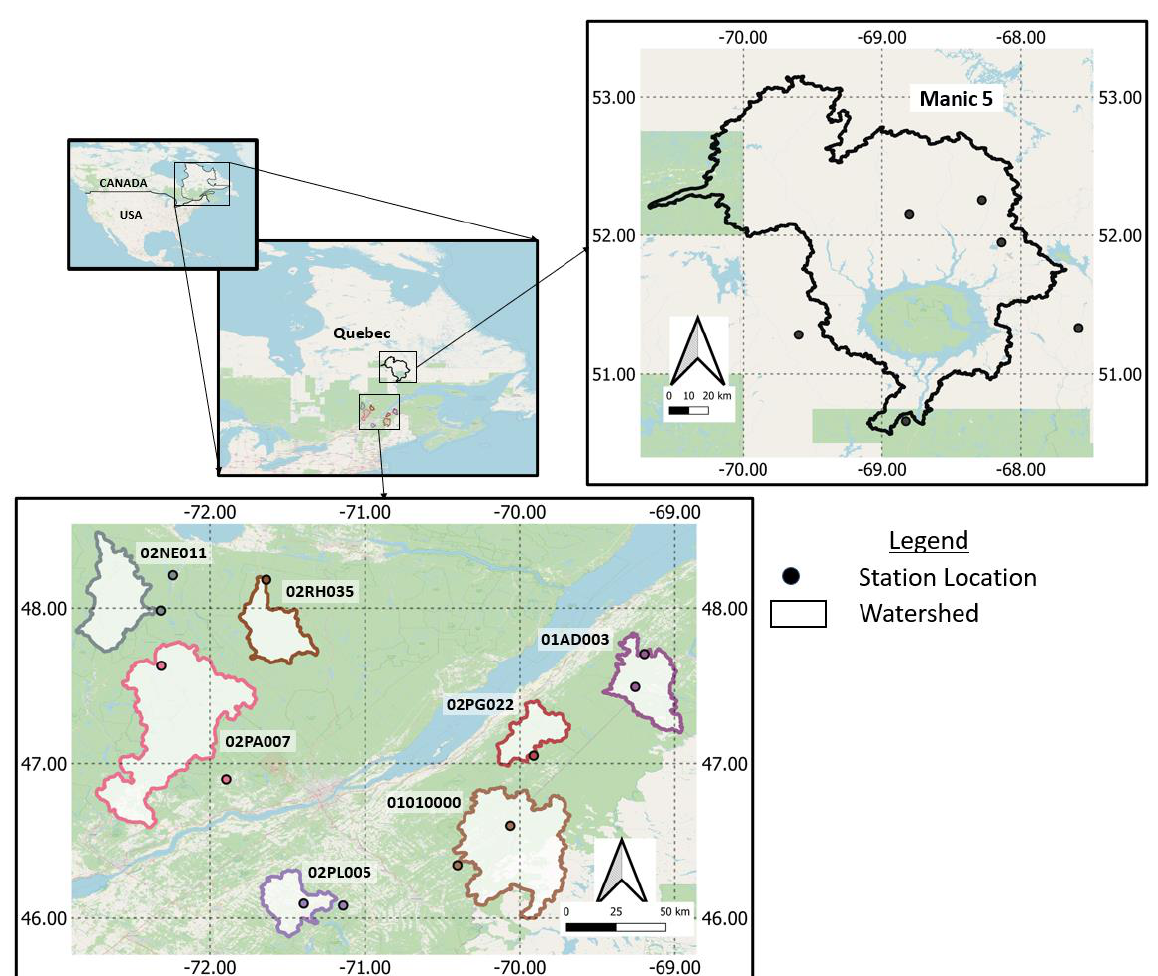
Figure 3. Study watersheds with location of SWE surveys (circular points). Watershed IDs taken from the HYSET database (Arsenault et al., 2020).